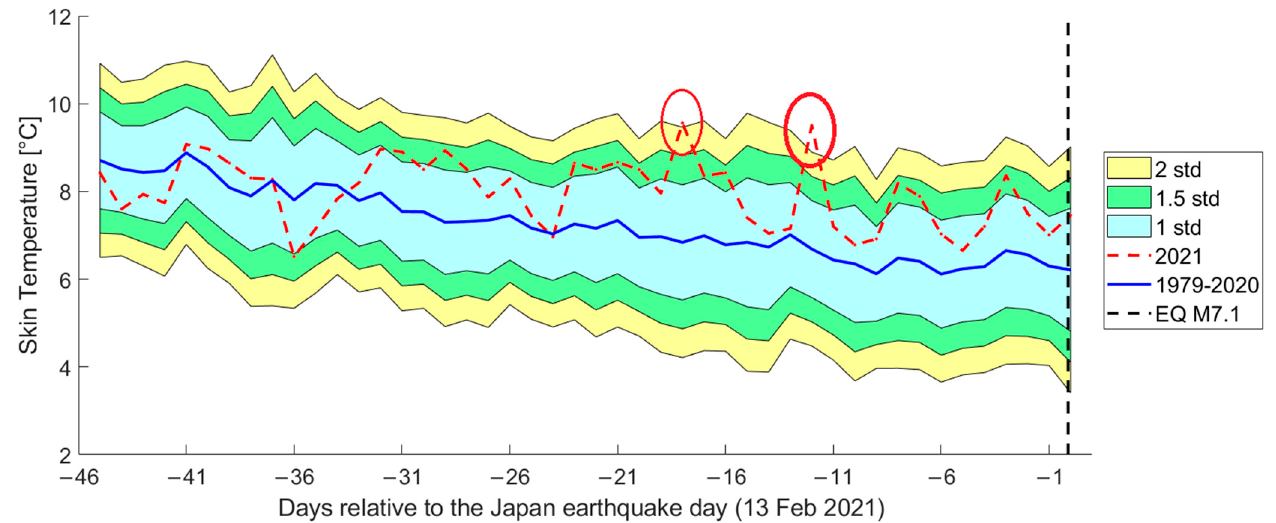
Figure 12. Atmospheric analysis of Skin Temperature (SKT) concentration in the 45 days before the Mw = 7.1 Japan 13 February 2021 earthquake in a square area of 6° size centred on the epicentre. We highlight the anomalies with red circles, where a bold red circle means a significant and more robust anomaly, to distinguish it with respect to weakly significant anomalies, at the threshold limit of two standard deviations, which was chosen for atmospheric data analyses.